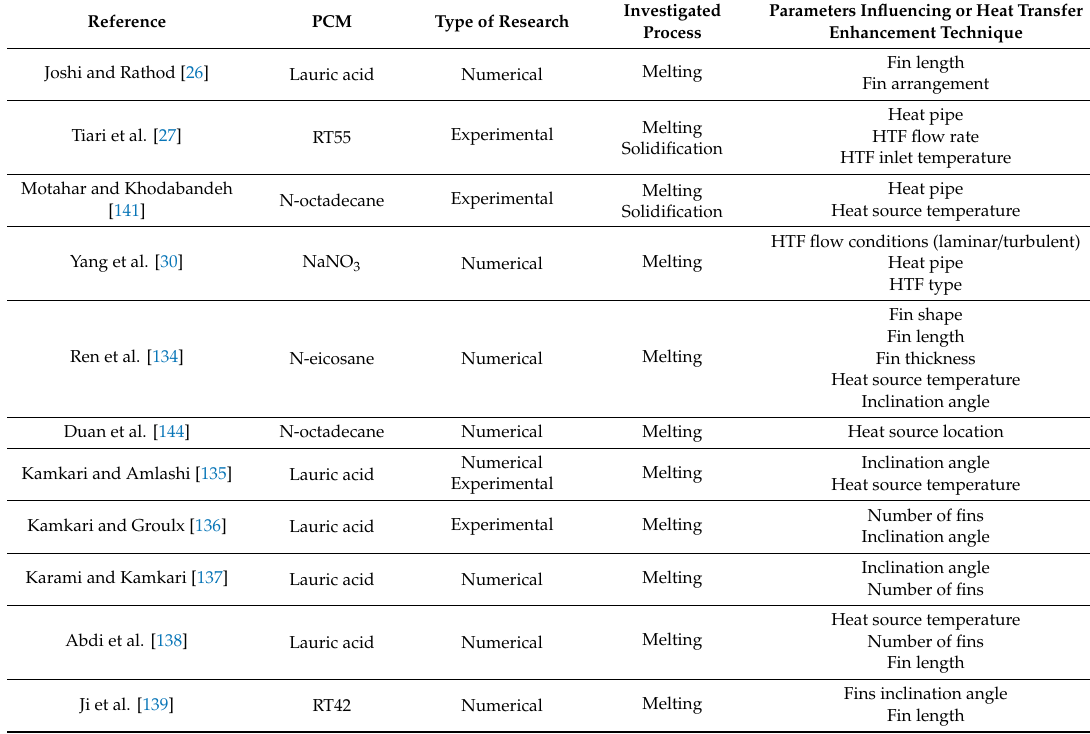
Table 8. Research on the enclosure-type heat exchangers.